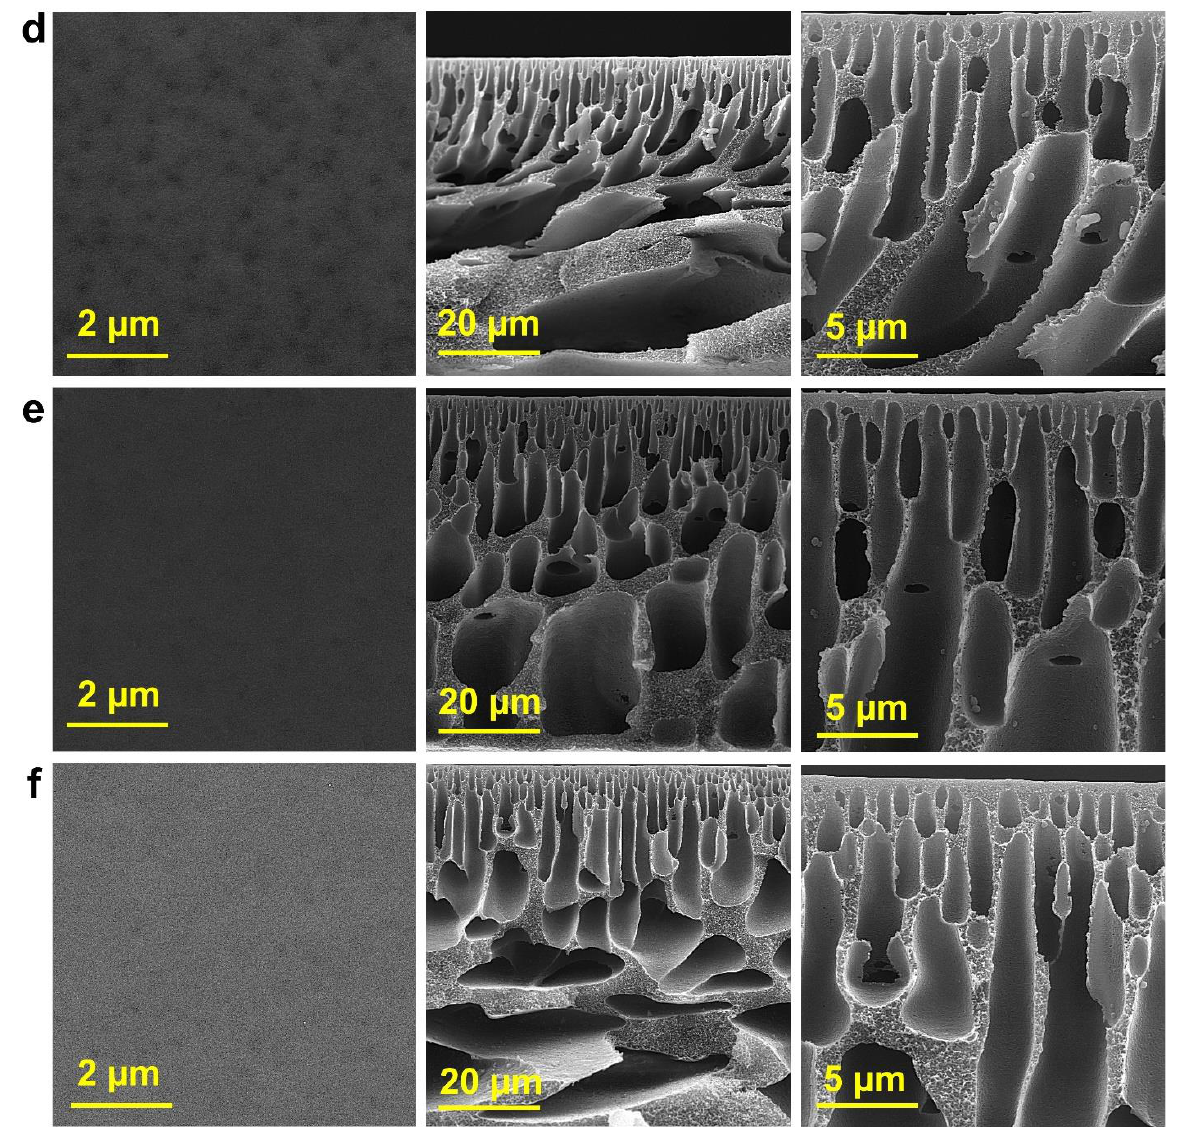
Figure 2. SEM micrographs from surface and cross-sections of various membranes at three different scales of 2, 5, and 20 µm: ( a ) M0, ( b ) M1, ( c ) M2, ( d ) M3, ( e ) M4, and ( f ) M5.